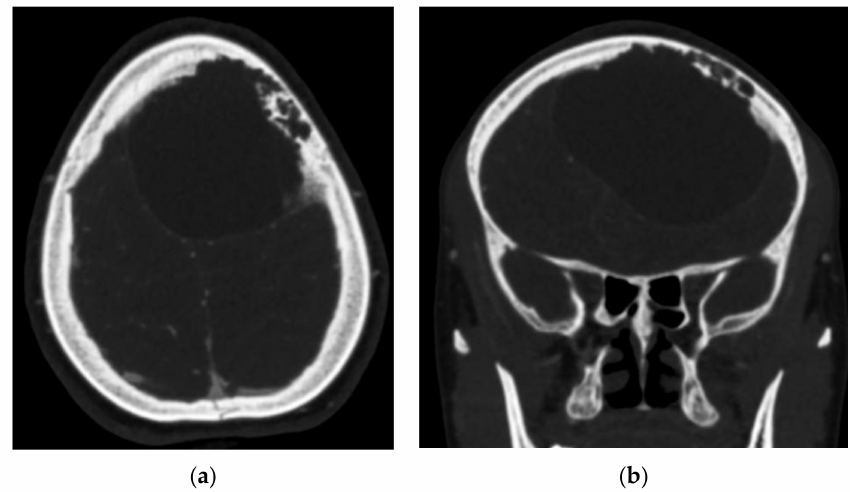
Figure 2. Head CT Scan bone window. Erosion of the frontal bone inner table. ( a ) axial; ( b ) coronal.